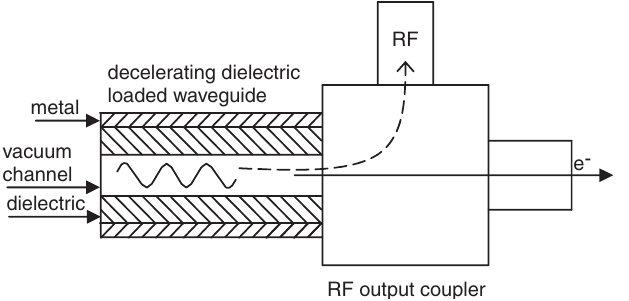
FIG. 2. Dielectric-loaded power extractor consists of a dielectric-loaded decelerator and an rf output coupler.